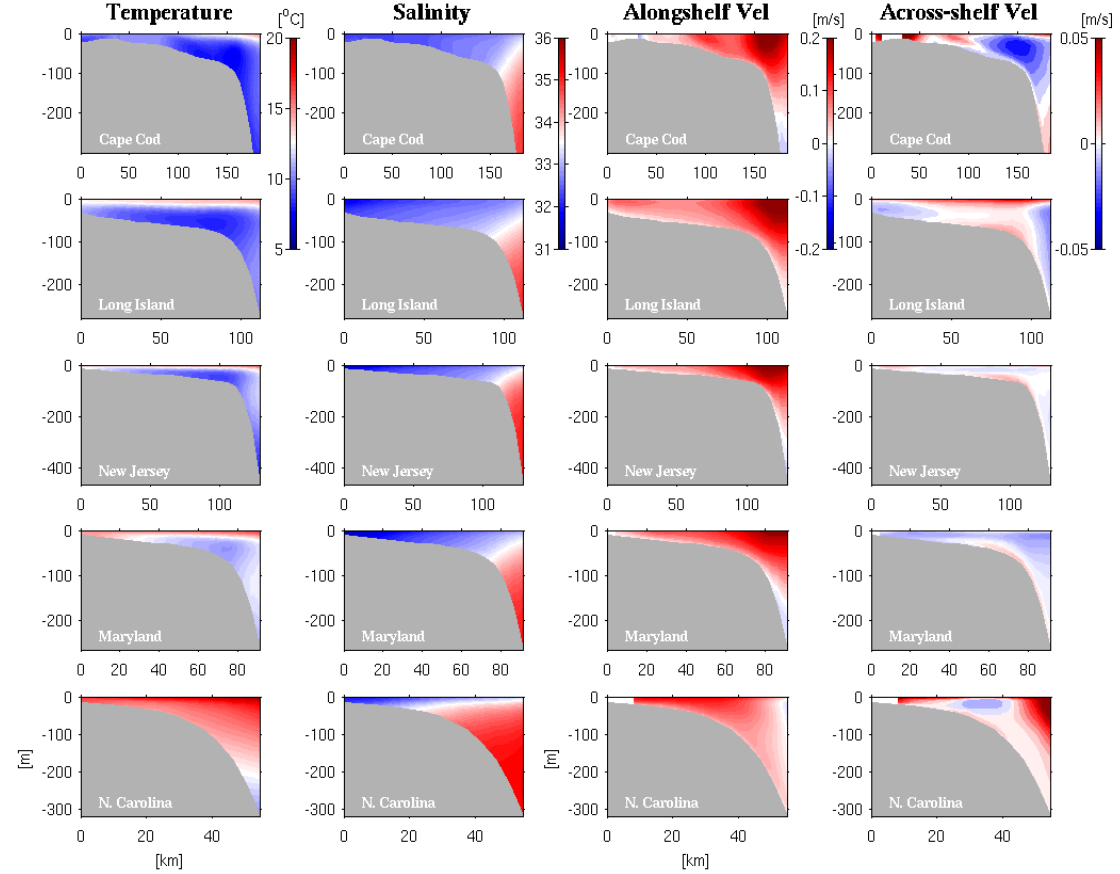
Figure 9. Mean cross-shelf transects (top transect to bottom transect is north to south) of temperature, salinity, alongshore and cross-shelf velocity. For velocity components, positive (red color) indicates equatorward and offshore, and negative (blue color) indicates poleward and